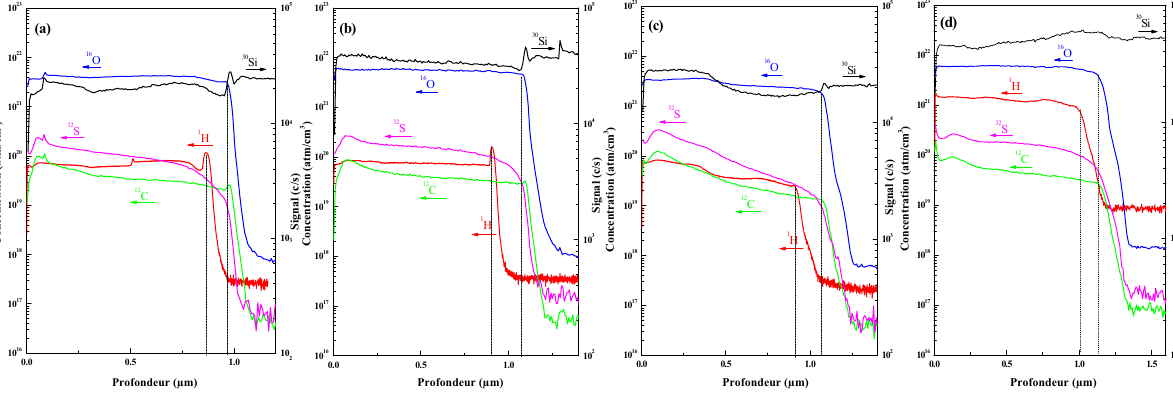
Figure 5: SIMS pro fi les of PTh/oxide PSi structures by applying: ( a ) 2 VCs, ( b ) 4 VCs, ( c ) 8 VCs, and ( d ) 12 VCs, at 50 mV · s − 1 .